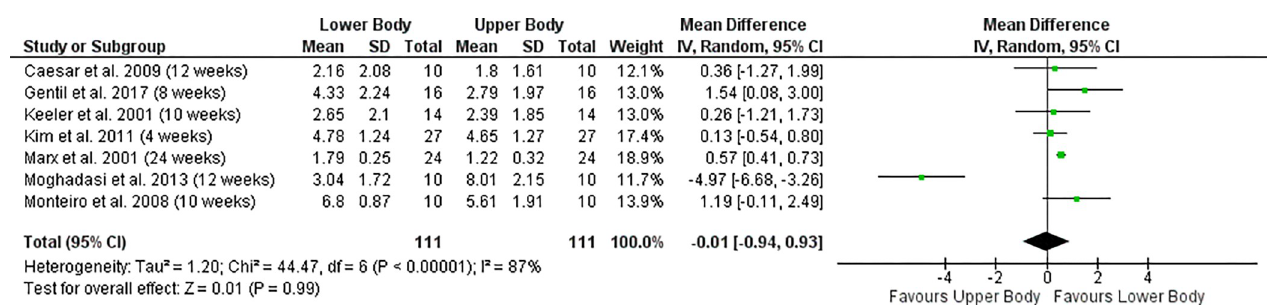
Fig 3. Forrest plot. Lower-Body gains compared to upper-body 1RM gains in beginner subjects.